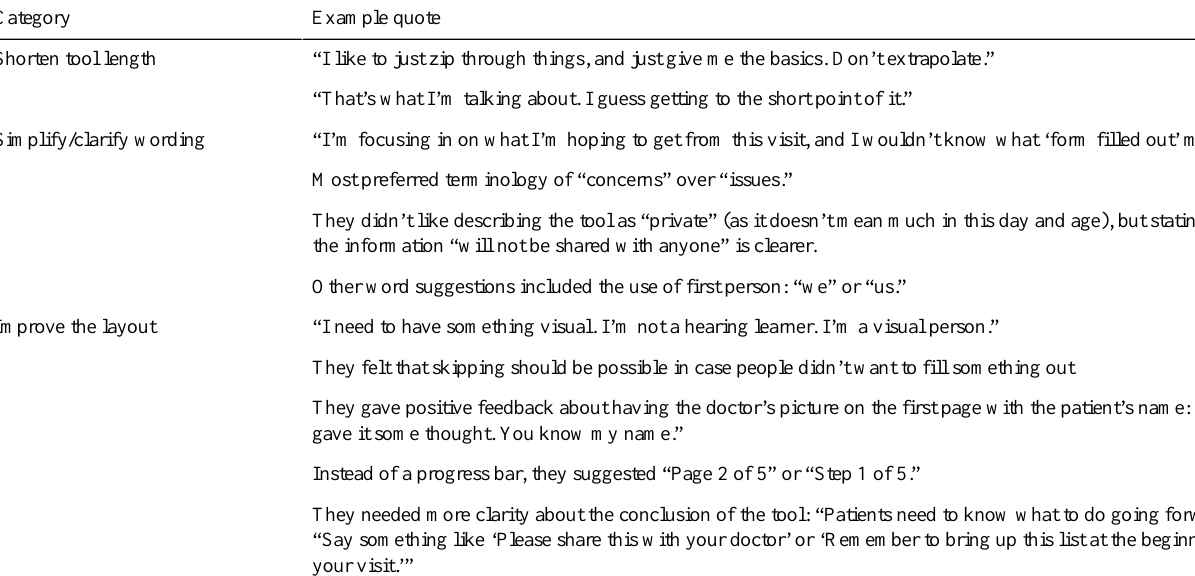
Table 3. Patient focus group feedback.